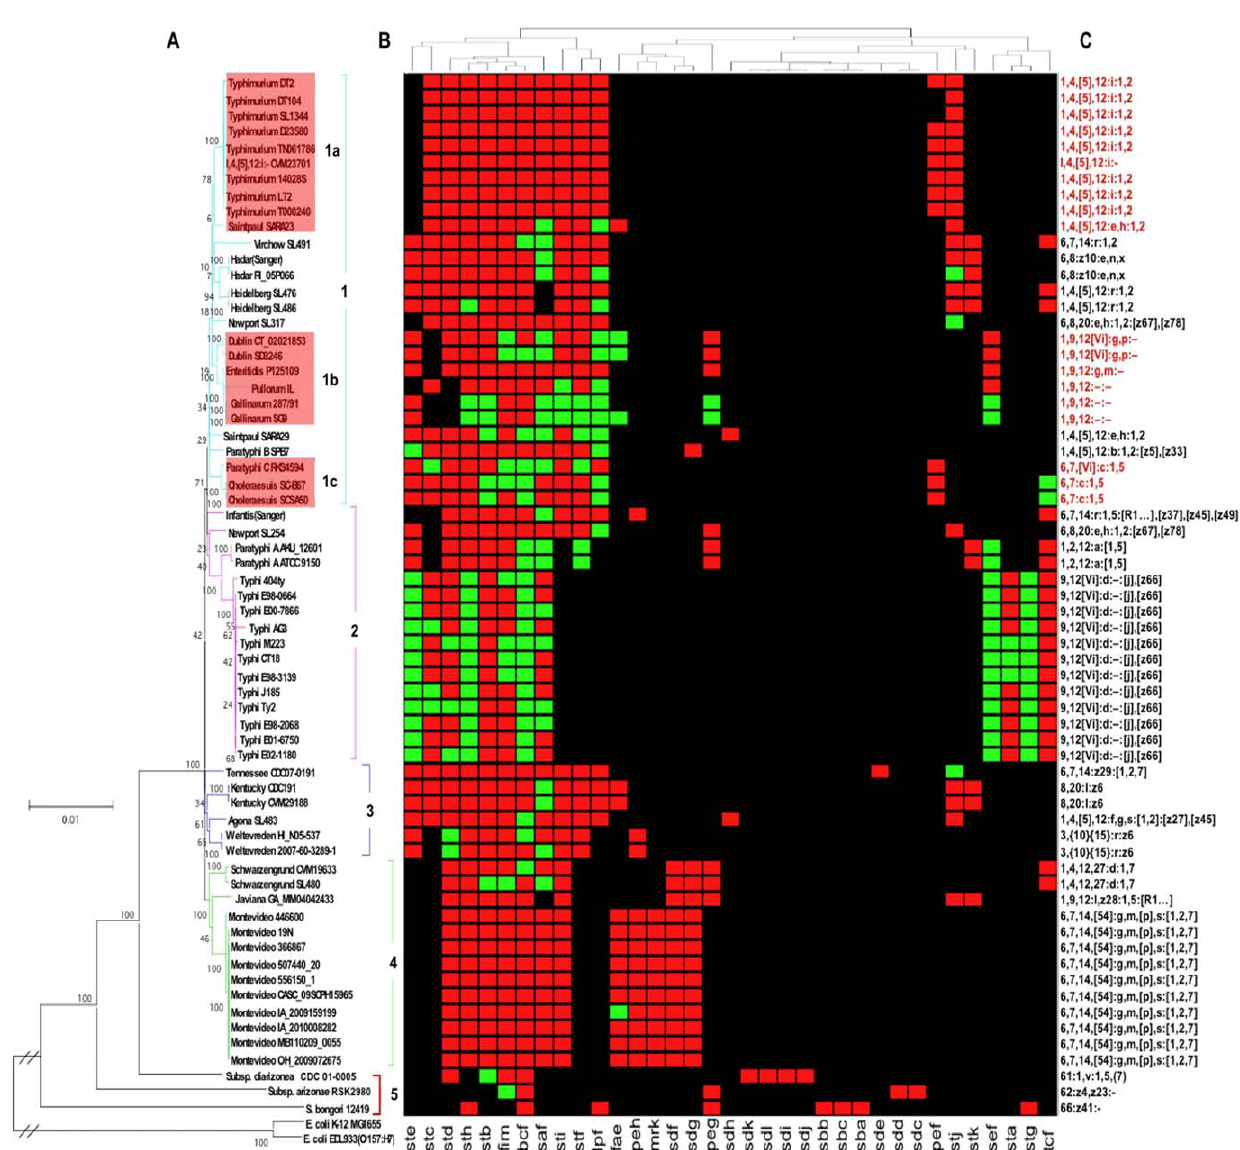
Figure 3. Correlation of Salmonella phylogenomic groups with specific collections of FGCs. On the left, phylogenomic tree of 90 Salmonella and two E. coli control strains, based on 45 highly conserved house-keeping genes totaling , 43 Kb. Clade 1 to 4 correspond to the clades shown in Figure 2, and clade 5 includes the few sequenced genomes from strains that were not S. enterica, subsp. I. The scale indicates the number of substitutions per nucleotide. On the top and heat map, hierarchical clustering support tree for the FGCs (MeV, complete linkage method with an euclidean distance threshold of 9.525, http://www.tm4.org). FGCs with or without pseudogenes were shown as green or red rectangles, respectively. On the right, Salmonella serovars (somatic O and flagellar H